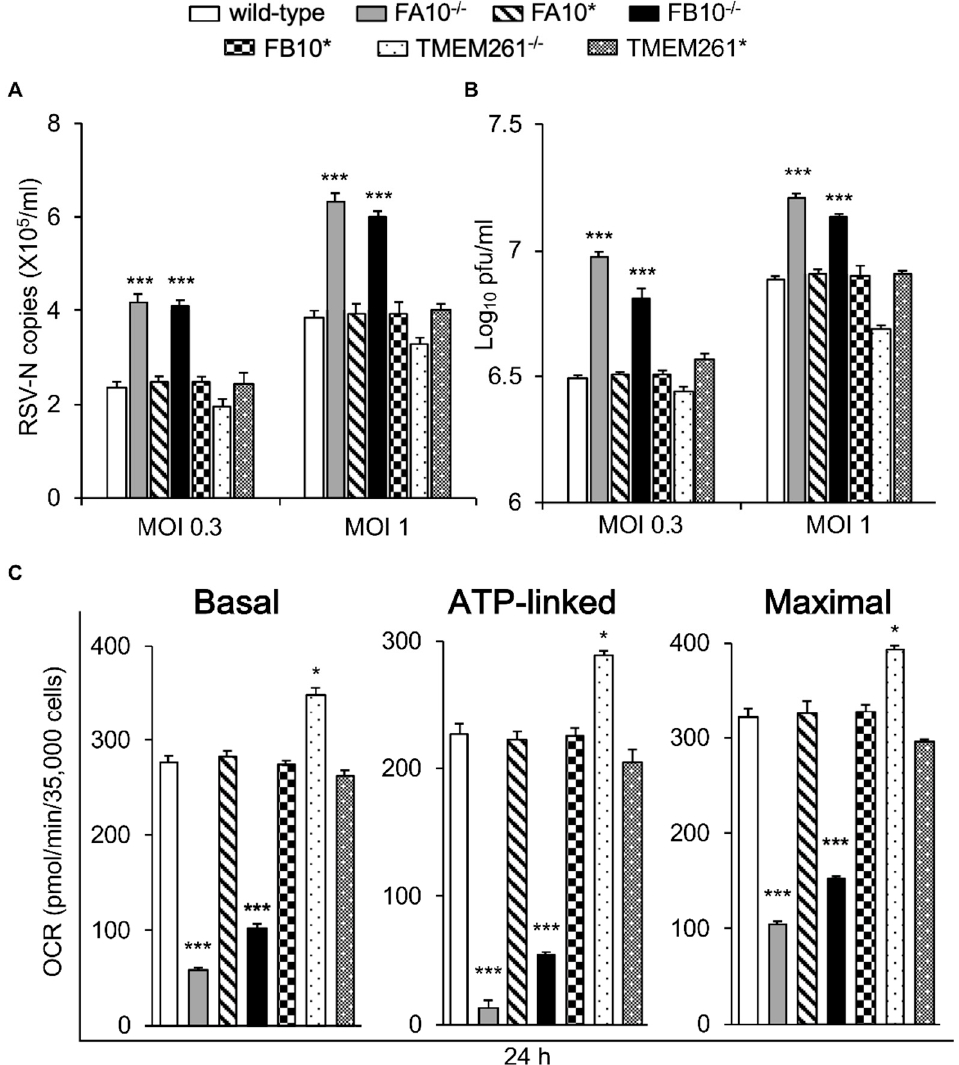
Figure 3. Correlation of infectious RSV virus production with impaired mitochondrial respiration in cell lines knocked out for specific mitochondrial genes and / or retrovirus-rescued. KO derivatives thereof lacking Complex I α subcomplex subunit 10 (FA10 − / − ), FB10 − / − , or transmembrane protein 261 (TMEM261 − / − ), as well as retrovirus-rescued controls (FA10*, FB10*, and TMEM261*) were ( A and B ) infected with RSV (MOI indicated) for 24 h prior to analysis for the cell-associated virus by ( A ) qPCR and ( B ) plaque assays to determine the viral RNA copy number and infectious virus (plaque forming units pfu / mL), respectively, or ( C ) assessment for their mitochondrial bioenergetic activities as per Figure 1B. Results represent the mean ± SEM ( n = 3 independent experiments, each performed in triplicate). *** p < 0.001, * p < 0.05 compared to the rescued or wild-type cells.